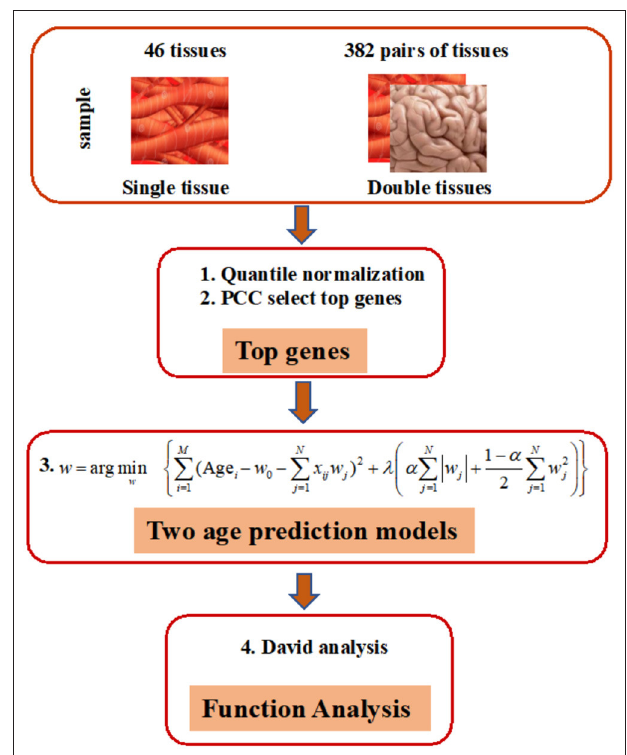
FIGURE 1 | Overview of elastic net method for building age-prediction model. 1. Normalize the original gene expression data from GTEx via quantile normalization. 2. Select the top 50, 100, 200, 400, 600, 800, 1,600, 3,200, and 6,400 genes, obtained via the Pearson correlation of the age and corresponding gene expression, and build the age-prediction model for each of 46 tissues. 3. Construct age-prediction model for multiple tissues as was done for single tissues. Because overlapping samples among three tissues are often less than 70, only two-tissue studies are contained in the current